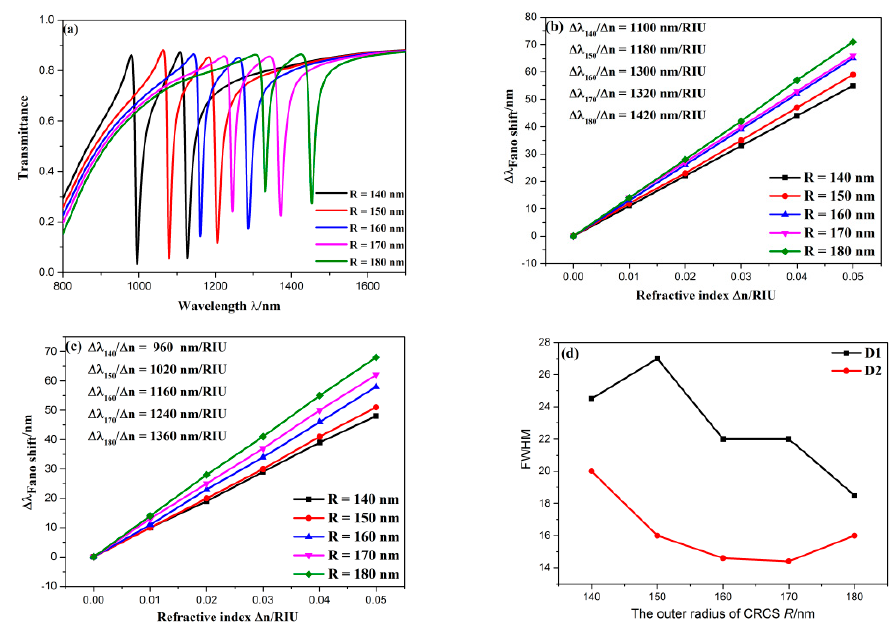
Figure 6. ( a ) Transmission spectra for diverse outer radius of CRCS; ( b ) fitting line of sensitivity at D1; ( c ) fitting line of sensitivity at D2; ( d ) the variation of FWHM with the rising of outer radius of CRCS.